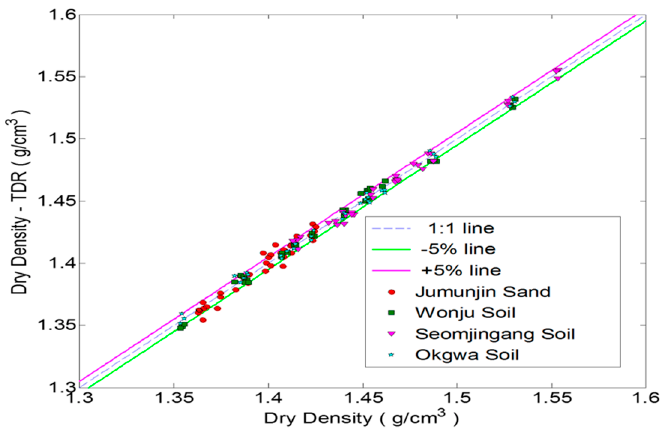
Figure 18. Dry density measured by the flat type TDR and the standard test.